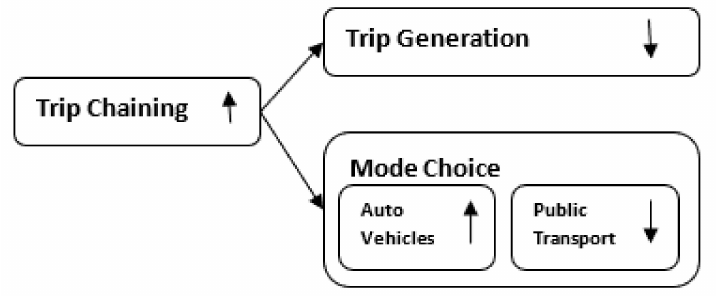
Figure 1. Overall effect of trip chaining on trip generation and mode choice. On the interaction between trip generation and trip chaining, mixed land use creates opportunities for increasing numbers of pass-by and multipurpose trips and directly reduces trip generation [24]. A pass-by trip is a trip to a land use because of passing the land use while travelling to another